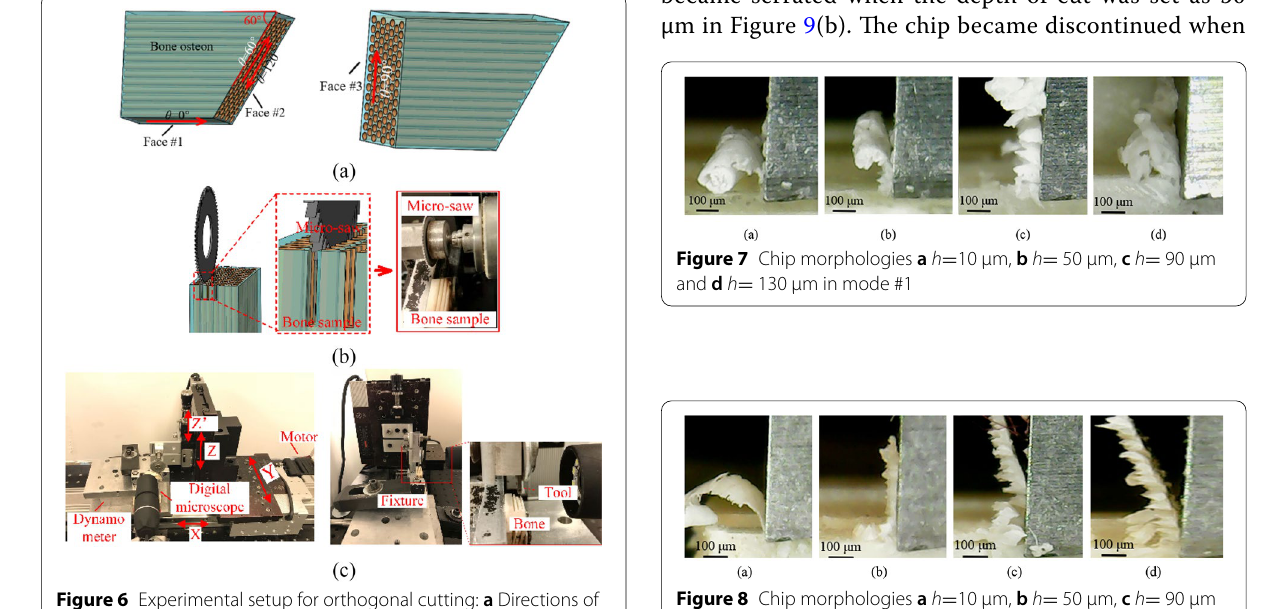
10 μm, b h 50 μm, c h 90 μm = = =